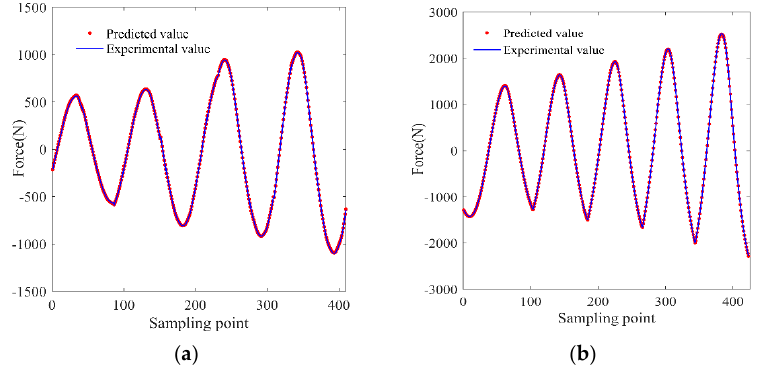
Figure 7. Comparison of output force between experimental and BPANN predicted results: ( a ) A = 0.05 mm; ( b ) A = 0.15 mm.